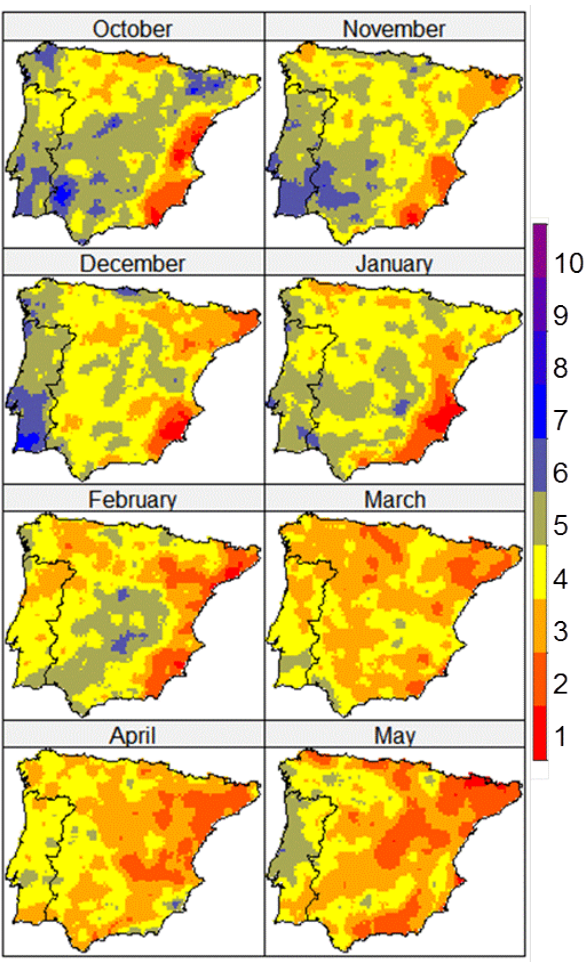
Figure 6 . Spatial and temporal distribution of the number of predictor WTs of the regression model for each month from October to May.